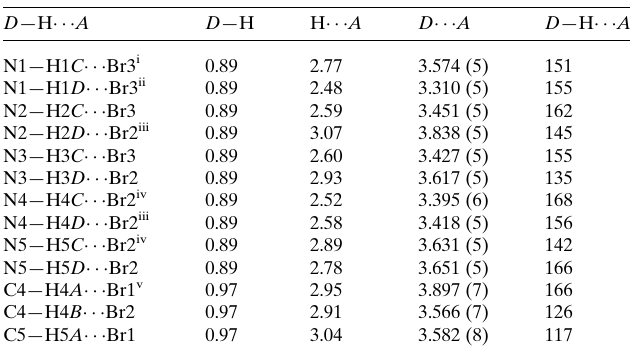
Table 1 Hydrogen-bond geometry (A˚ , (cid:4) ).